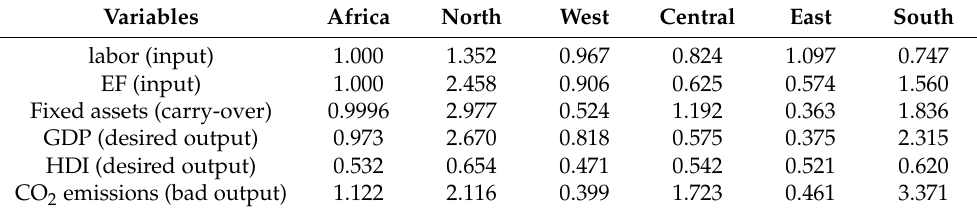
Table 3. Mean normalization of the summary statistics across the regions in Africa. Variables